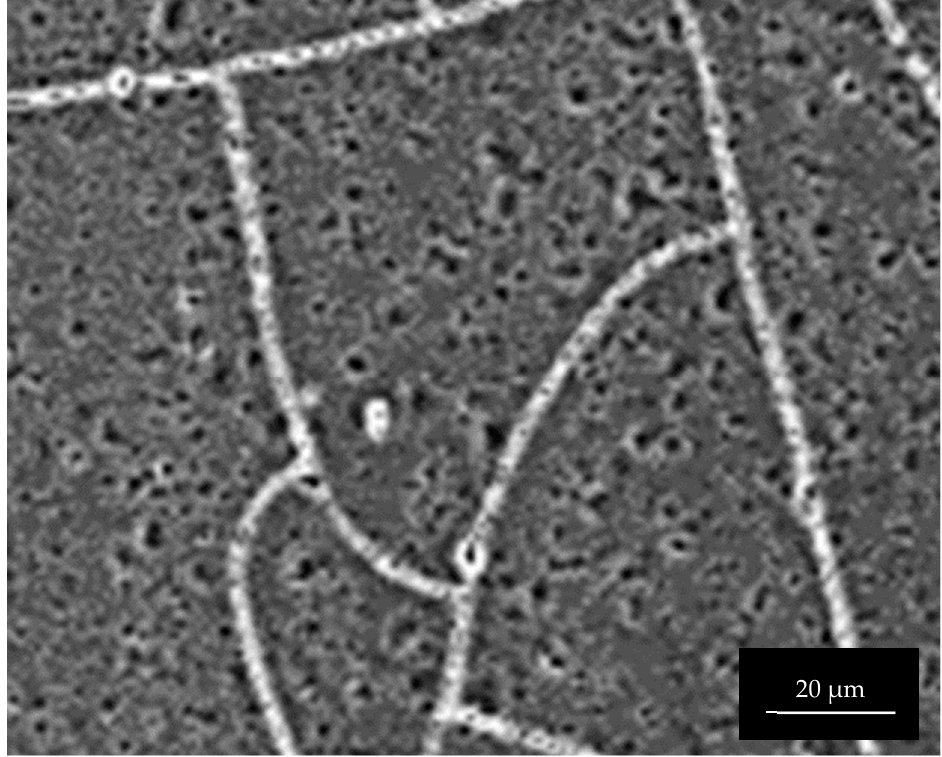
Figure A6. Surface of 3003-Al alloy with t a = 3600 s and t s = 1200 s. Figure 10c was enlarged to 500%.